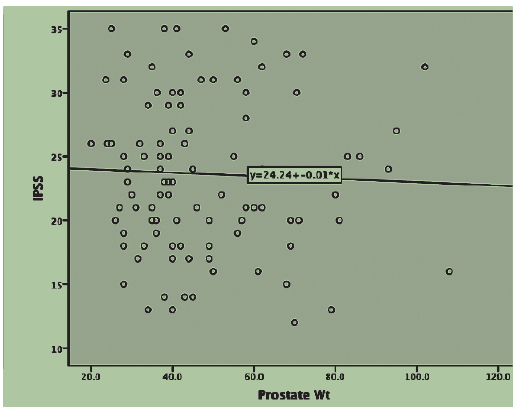
Figure 4. Scatter diagram showing correlation between Prostate Wt and IPSS